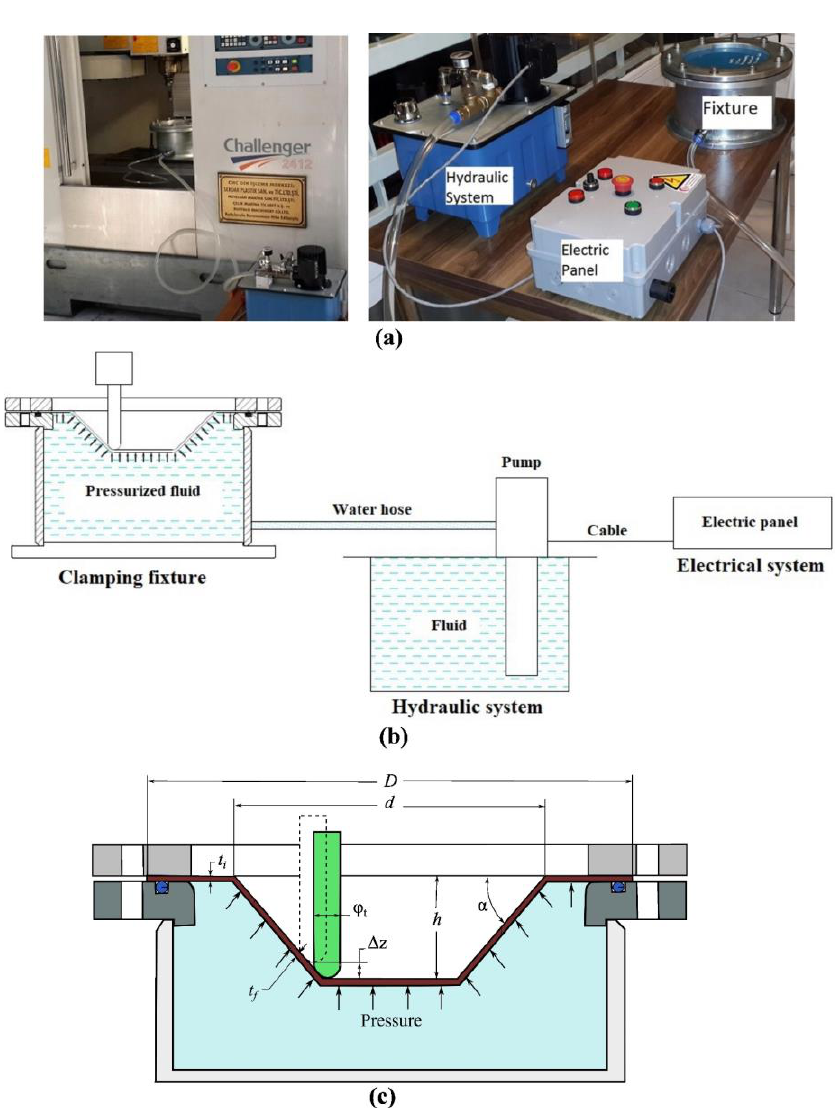
Figure 1. Experimental setup ( a ), detailed schematic of the setup ( b ), and process parameters ( c ). Using Computer Aided Manufacturing (CAM), the processing G-codes were extracted and sent to the CNC machine in order to deform the sheet material into the desired shape. A three-axis CNC vertical milling machine was utilised to mount the experimental equipment. The tool rotation direction is clockwise, speed is 800 rpm, machining direction is counter-clockwise, step- down size is ∆ z = 0.5 mm, and feed rate is 1000 mm/min. The forming tool is an SAE 430B manganese bronze alloy with a 16 mm diameter and a spherical end. For sheet material with a thickness of t i = 0.7 mm and a diameter of D = 285 mm, the forming diameter is d = 180 mm, form height is h = 50 mm, and forming angle is α = 4 5°. To assure accuracy, all experiments and measurements were repeated three times, and the average of the results was calculated. Due to the high manganese content of this tool, its resistance to wear is exceptional. Figure 2 depicts the utilised forming tool, whereas Table 1 outlines its elemental composition.